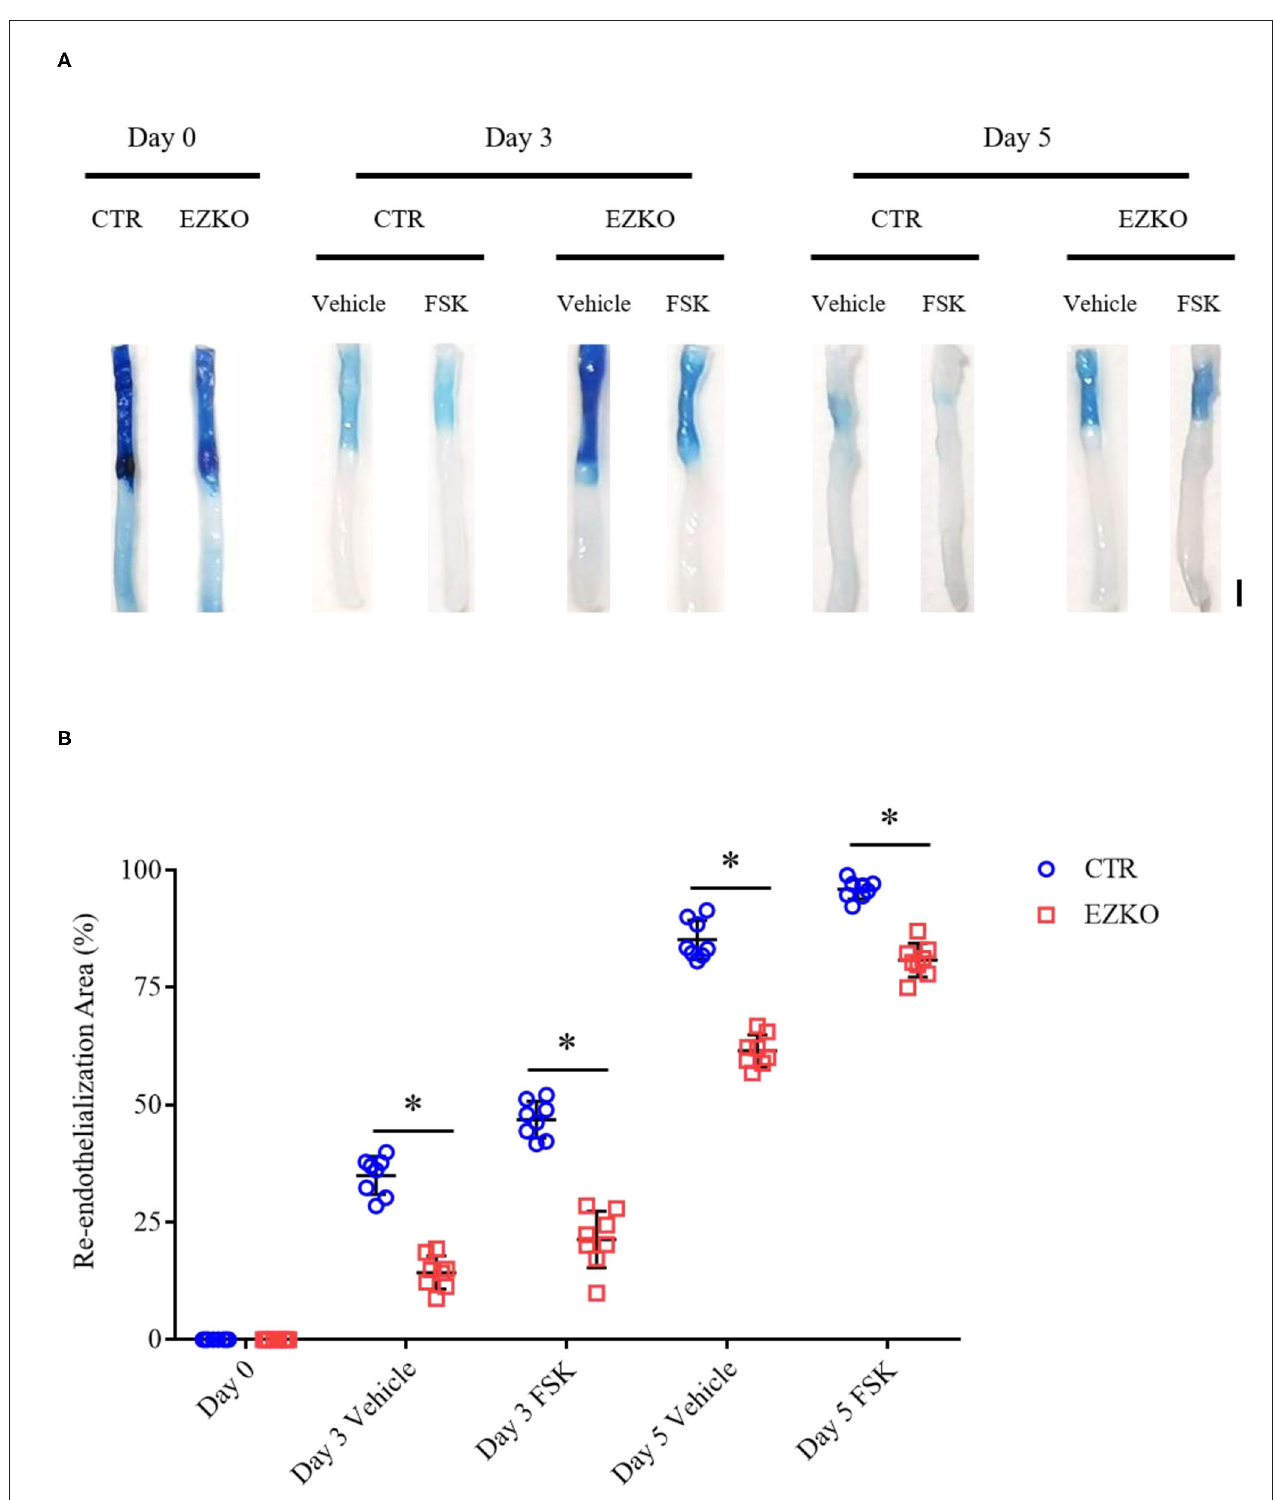
FIGURE 9 | Endothelium-specific deletion of zyxin compromises re-endothelialization in injured arteries under forskolin stimulation. (A) Representative images of endothelial denudation assessed by Evans Blue staining of carotid arteries 0, 3, and 5 days after injury with forskolin (FSK: 10mg kg − 1 , daily injection) or vehicle treatment (scale bar, 1mm). (B) Quantification of the re-endothelialization area after injury. Mean ± SD, n = 8, * P < 0.05. Test of normality: P > 0.05, test of homogeneity: P > 0.05. WT, wild-type; EZKO, endothelium-specific zyxin knockout; FSK, forskolin.